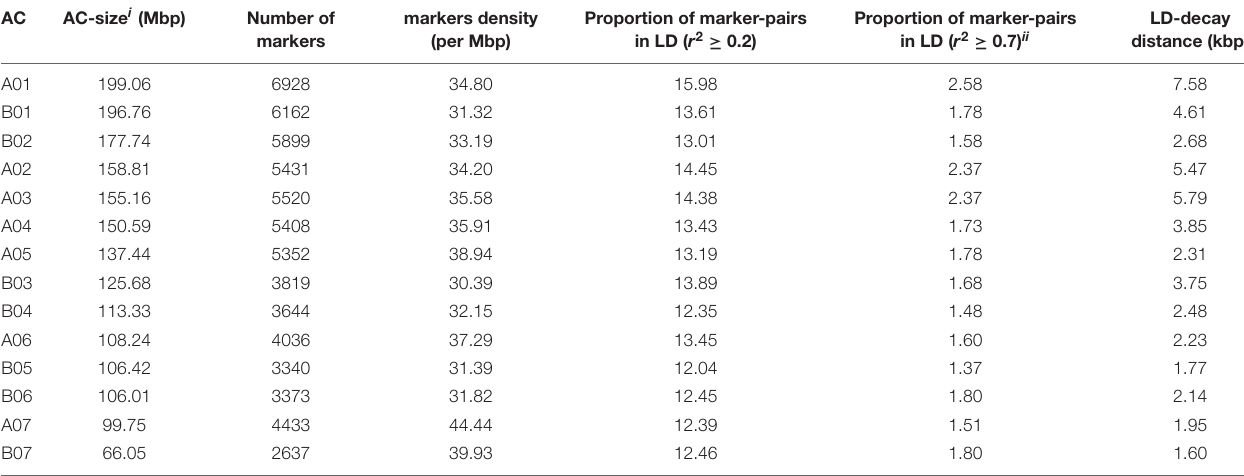
FIGURE 2 | Distribution and density of silicoDArTs (A) and SNPs (B) on the fourteen assembled chromosomes (AC) of the Napier grass genome. The number of markers mapped per AC is shown on the x -axis. The markers that were not mapped are indicated by a UM and those markers that were mapped onto different scaffolds are indicated by Scaffold. TABLE 2 | Density and distribution of markers, proportion of pairwise marker in linkage disequilibrium (LD) and the average LD-decay distance in each of the 14 assembled chromosomes